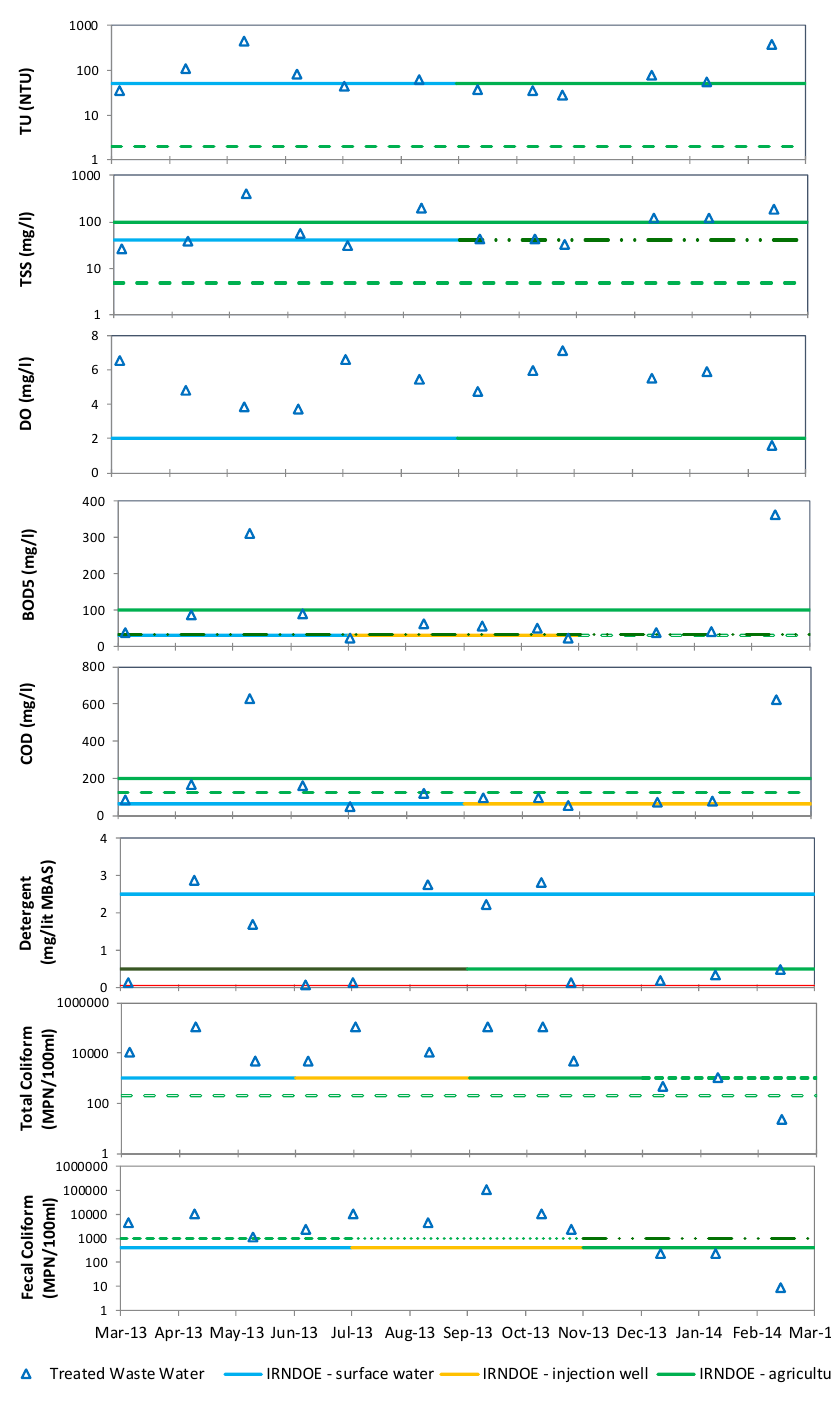
Fig. 3: Concentrations of FC,TC, detergents, COD, BOD, DO, TSS and TU parameters in the collected samples compared to the applied standards